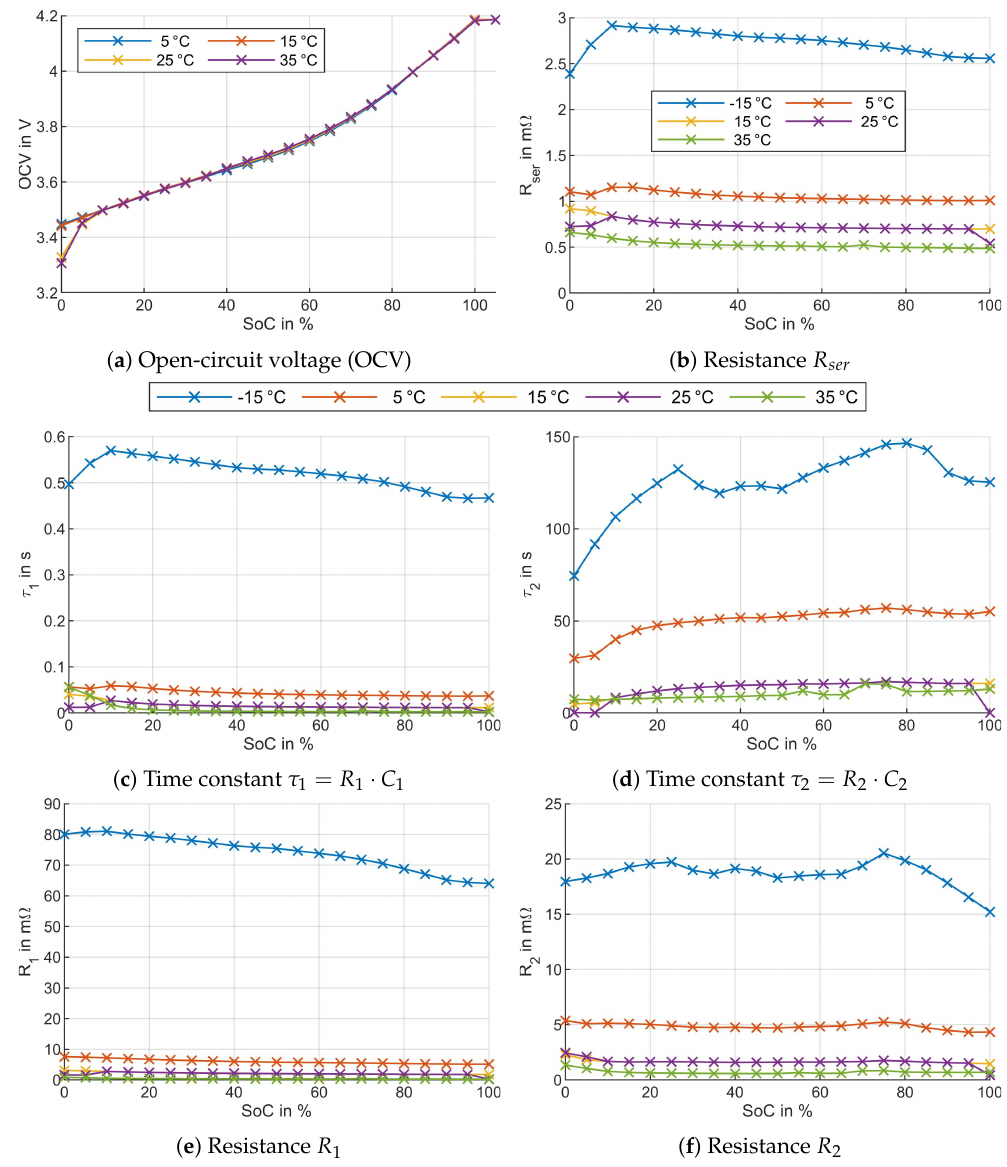
Figure 6. Electrical parameters of Li-Tec 52Ah LiNiMnCoO 2 pouch cell. Table 6. Traction battery pack and module dimensions.